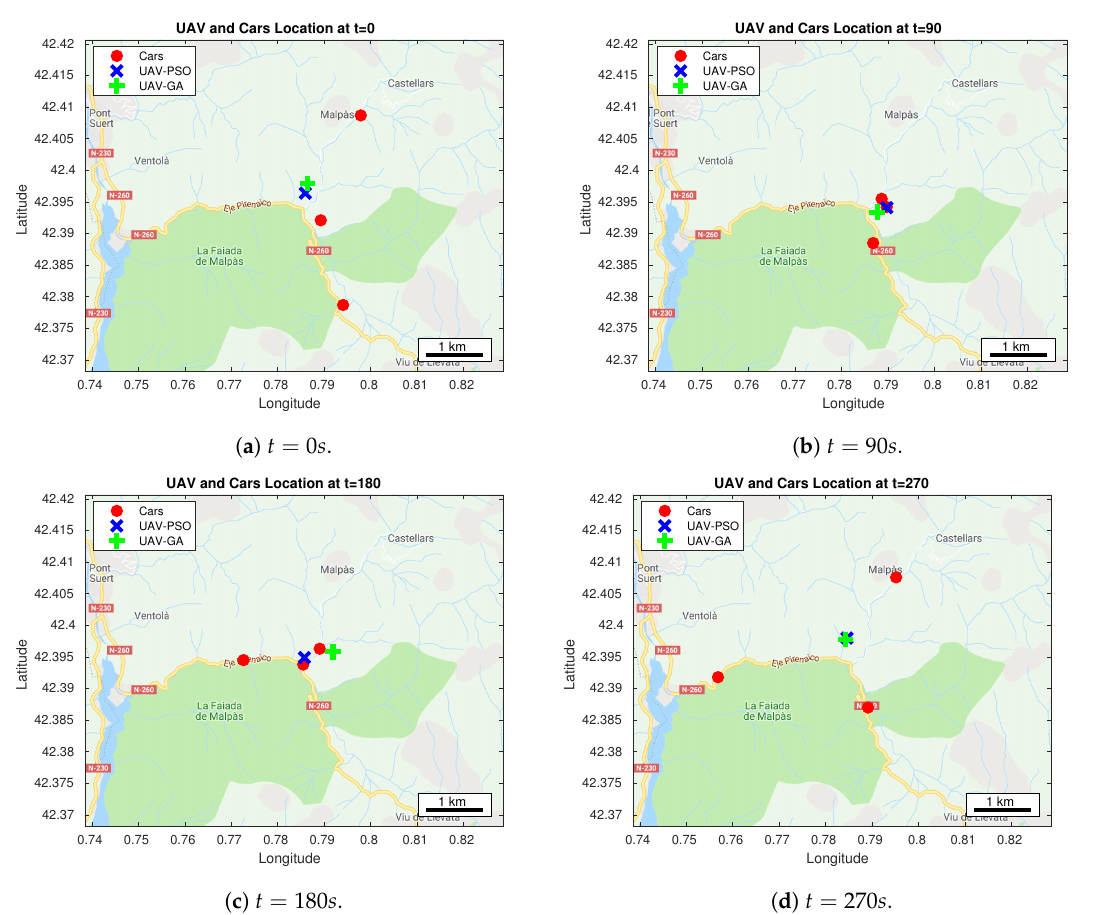
Figure 5. UAV and cars’ locations obtained at different timings by using both